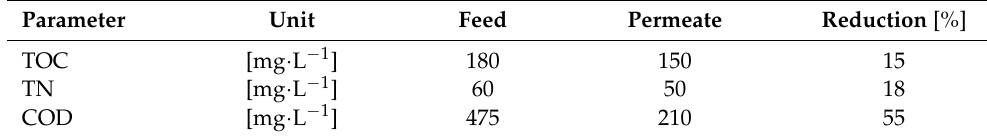
Figure 5. Permeability for ultrafiltration with flat sheet membrane 30 kDa. Table 5. Rejection by means of UH030 flat sheet membrane at 80%